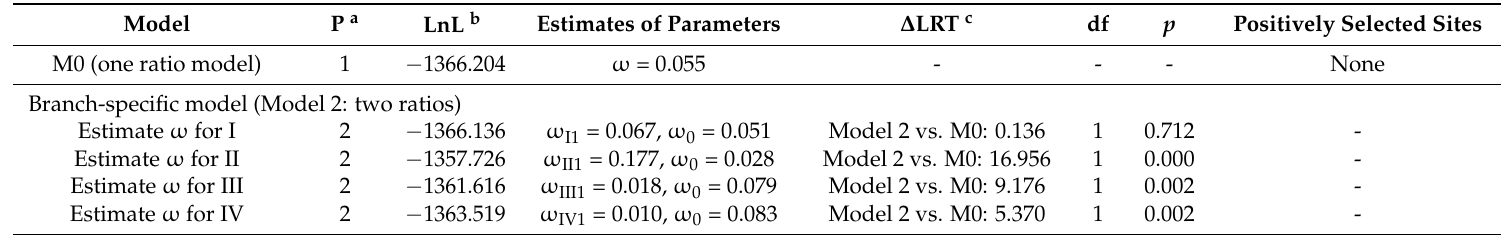
Table 1. Parameter estimates and likelihood ratio tests for the branch model.